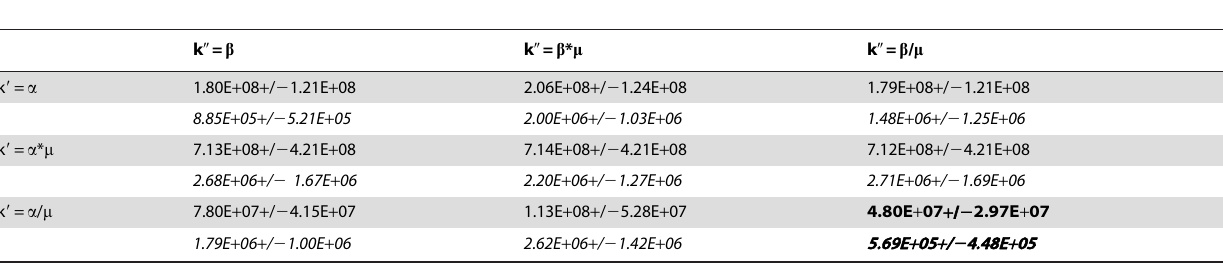
Table 2. Mean sum of squared residuals associated to different solutions to solve equation (2).